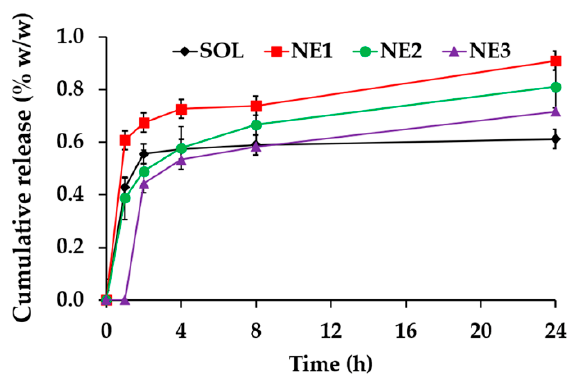
Figure 15. Release profile of C. militaris extract (CW) from solution (SOL) and nanoemulsions containing various content of Tween ® 85, including 5% w / w (NE1), 10% w / w (NE2), and 15% w / w (NE3). The letters a denoted significant difference between different formulations analyzed using one- way ANOVA with post-hoc Tukey test ( p < 0.05).